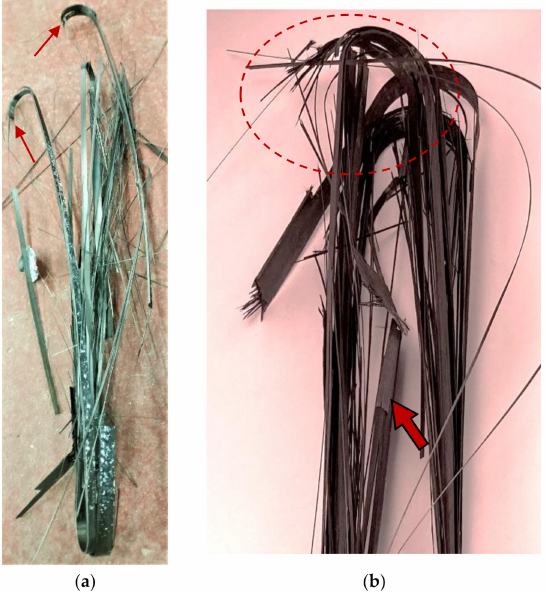
Figure 20. Strap failure modes in SS tests at 24 ( a ) (left) and 60 ◦ C ( b ) (right).